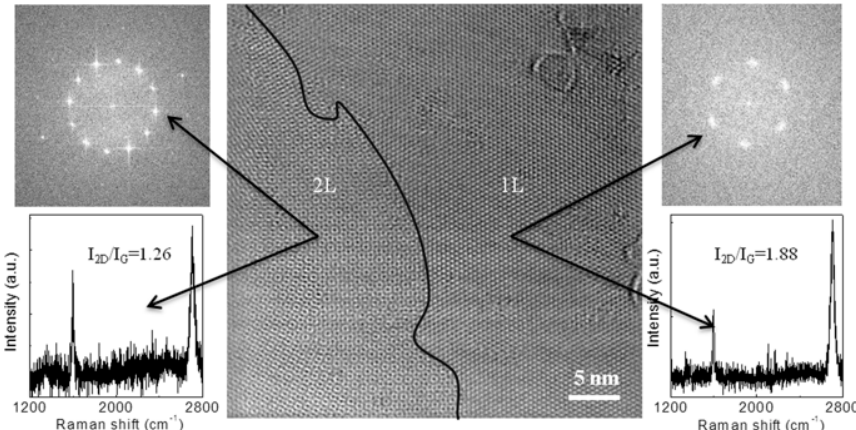
Figure 34. TEM analysis of CVD graphene flake from ethanol prepared with 4 h growth time. The HRTEM image showing both monolayer and bilayer graphene regions Moire patterns as a result of rotational misalignment of the two graphene layers are observed in the bilayer region. Hexagonal selected area electron diffraction patterns of the monolayer and bilayer graphene reveal the superior crystallinity. Their representative Raman spectra are illustrated in the bottom panel with I 2D / I G ratio of 1.88 and 1.26 for 1 L and 2 L, respectively (reprinted with permission from [209]).